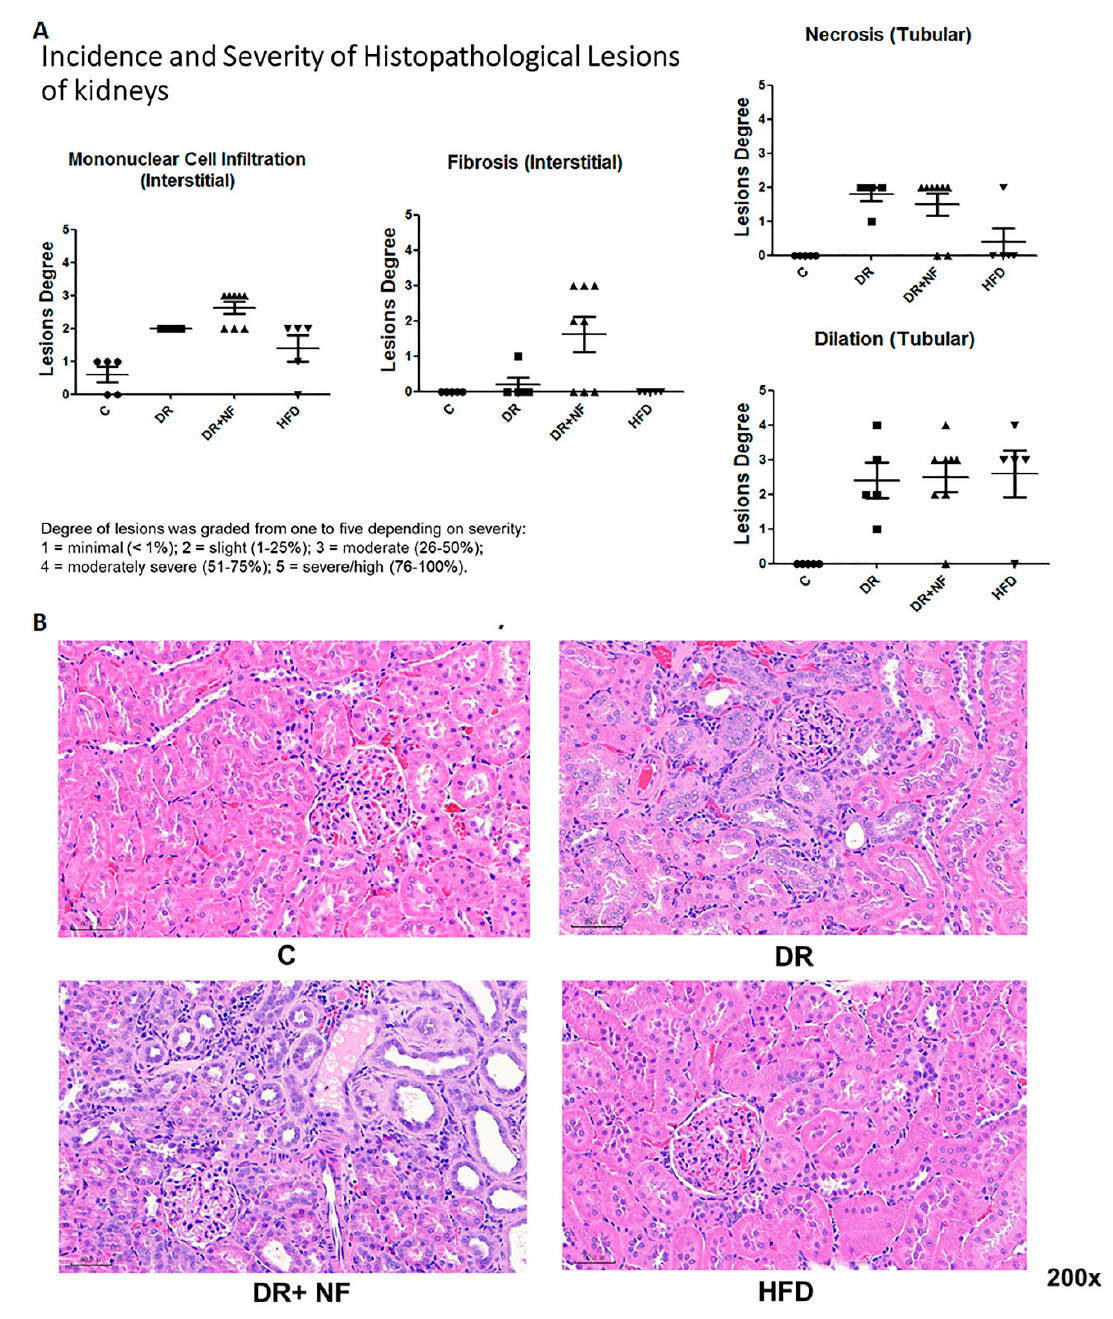
Figure 3. Hematoxylin and eosin (H+E) staining of renal histology in rats ( n = 3 in each group) ( A ) In renal tissue, DR+NF exhibited slight to moderate lesions (degree = 25–50%), including monocyte cell infiltration, interstitial fibrosis, tubular necrosis, and tubular dilatation compared to the controls. More conspicuously, DR+NF caused more severe fibrosis than DR only ( B ) H+E staining (magnification 200×) showed diffuse cellular infiltration, including lymphocytes and eosinophils (blue) and tubulitis in DR+NF rats, followed by the DR group. Damage observed in the HFD and control groups was minimal.